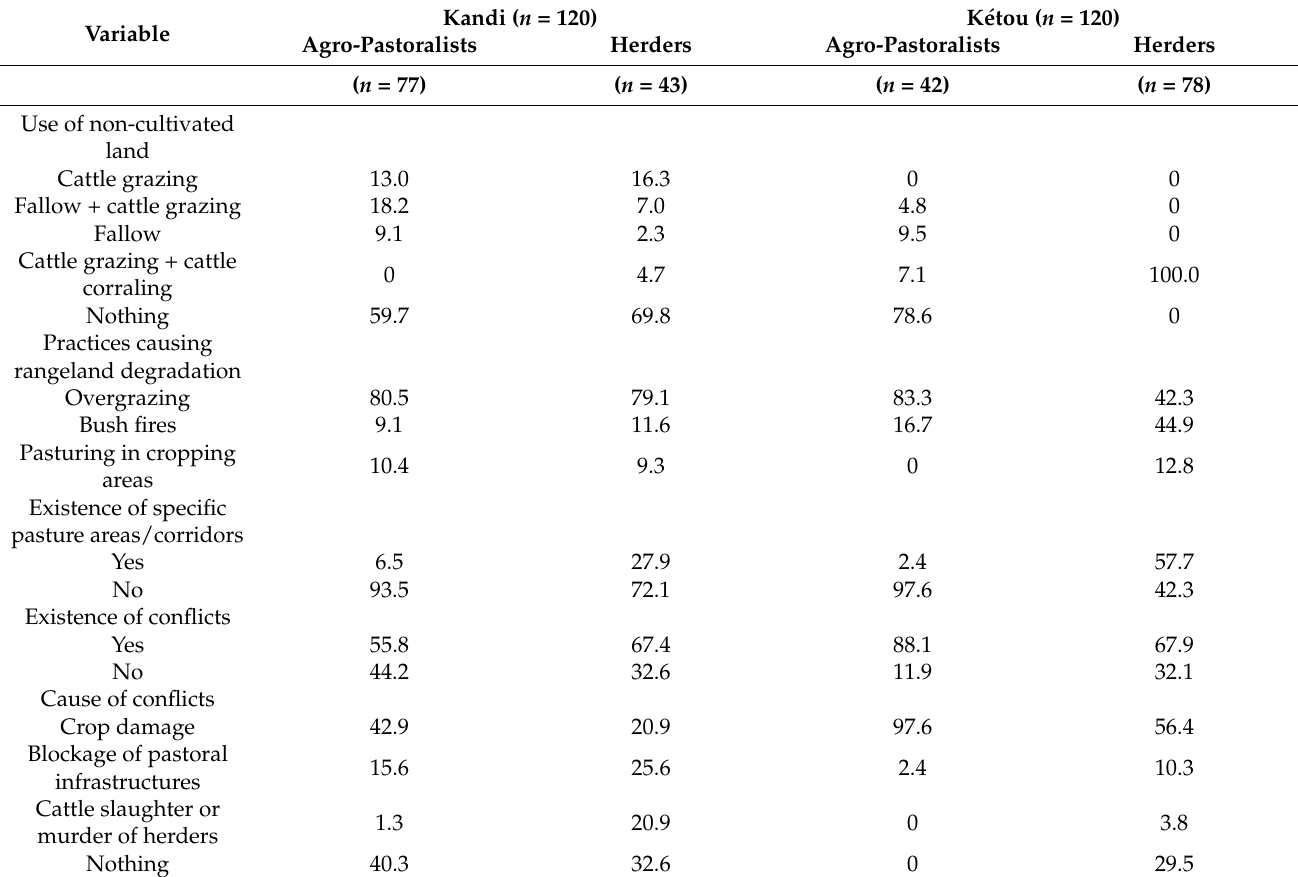
Table 2. Rangeland use and management by agro-pastoralists and cattle herders from Kandi ( n = 120) and K é tou ( n = 120) in Benin. Values depict percent of responses per group.